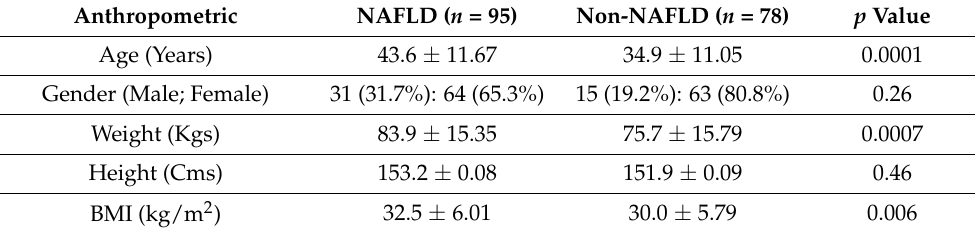
Table 2. Anthropometric measurements of NAFLD and non-NAFLD subjects involved in this study. Anthropometric NAFLD ( n =